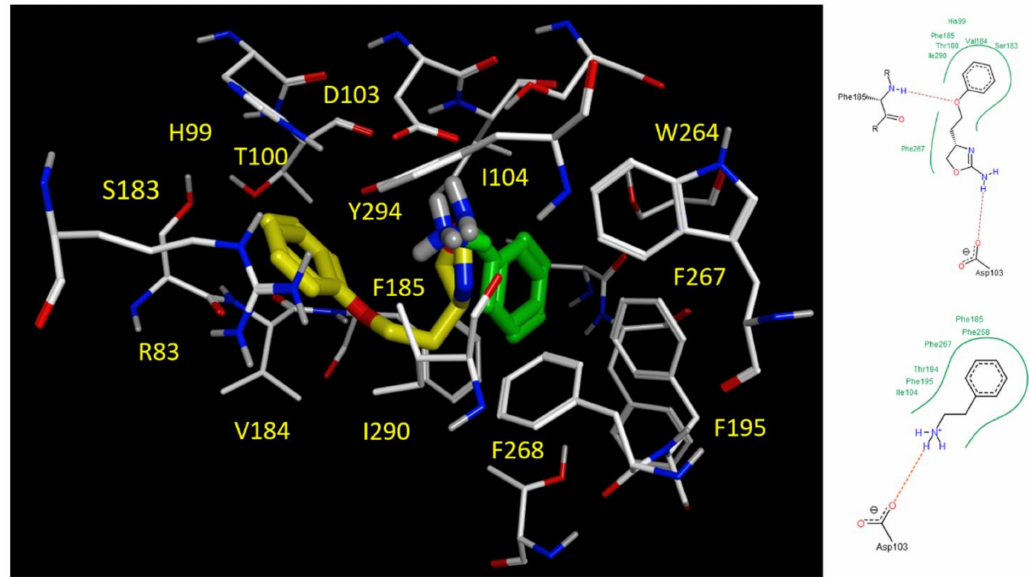
Figure 10. Docking mode of the potent oxazoline 20b ( C atom; yellow) and of β -phenylethylamine ( β -PEA) ( C atom; green) at the h TAAR1 putative binding site ( left ). Ligands are shown as sticks. The most relevant residues are labelled. A schematic perspective of the most relevant H-bonds experienced by the two agonists is also shown ( right